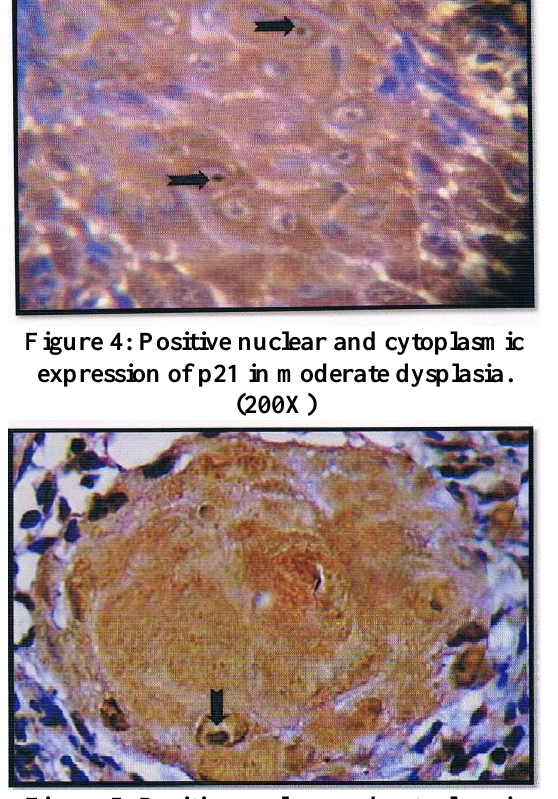
Figure 5: Positive nuclear and cytoplasmic expression of P21 in well differentiated SCC (400X). Table 1: Descriptive statistics and markers’ comparison in each group Groups